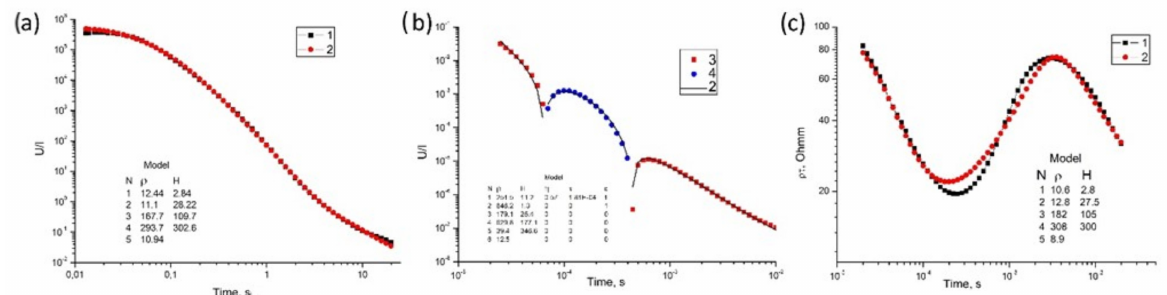
Figure 6. Examples of the curve for a one-dimensional horizontally layered medium at point 330 ( a ), RMS 4.6 %; the curve complicated by the effect of IP in the form of a signal transition to a negative area at point 340 ( b ) RMS 9.3 %; apparent resistivity curve complicated by the three-dimensional inhomogeneity of the medium at the picket 334 ( c ), RMS 12%. (1 is the experimental curve; 2 is the theoretical curve; 3 is the positive signal; 4 is the negative signal. Model: (cid:36) is the resistivity of the layer (Ohm · m); H is the layer thickness (m), η is the chargeability (0 ≤ η ≤ 1), τ is the relaxation time (ms), c is the exponent (0 < c ≤